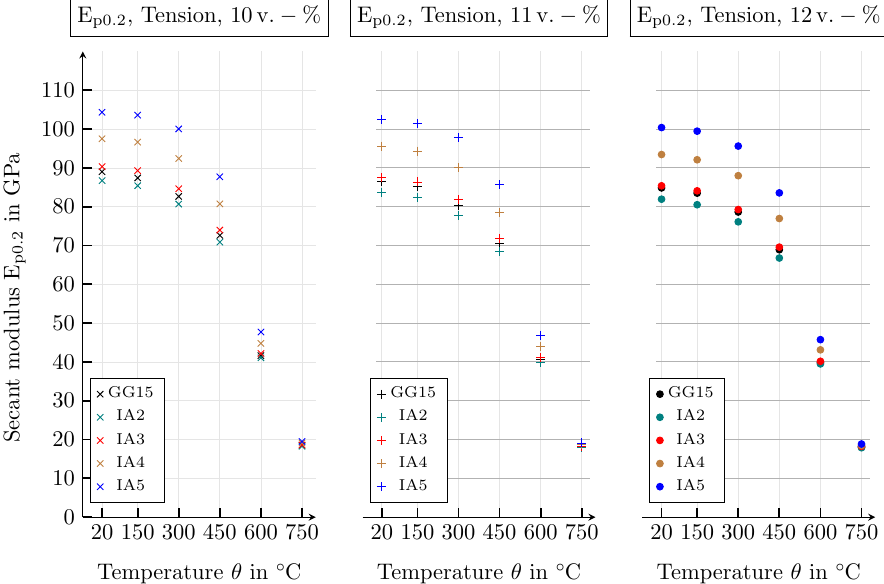
Figure 23. Secant moduli of all graphite classes with graphite flake volume fractions of 10, 11 and 12v. %, evaluated for the temperatures 20, 150, 300, 450, 600 and 750°C, at a tensile strain of −